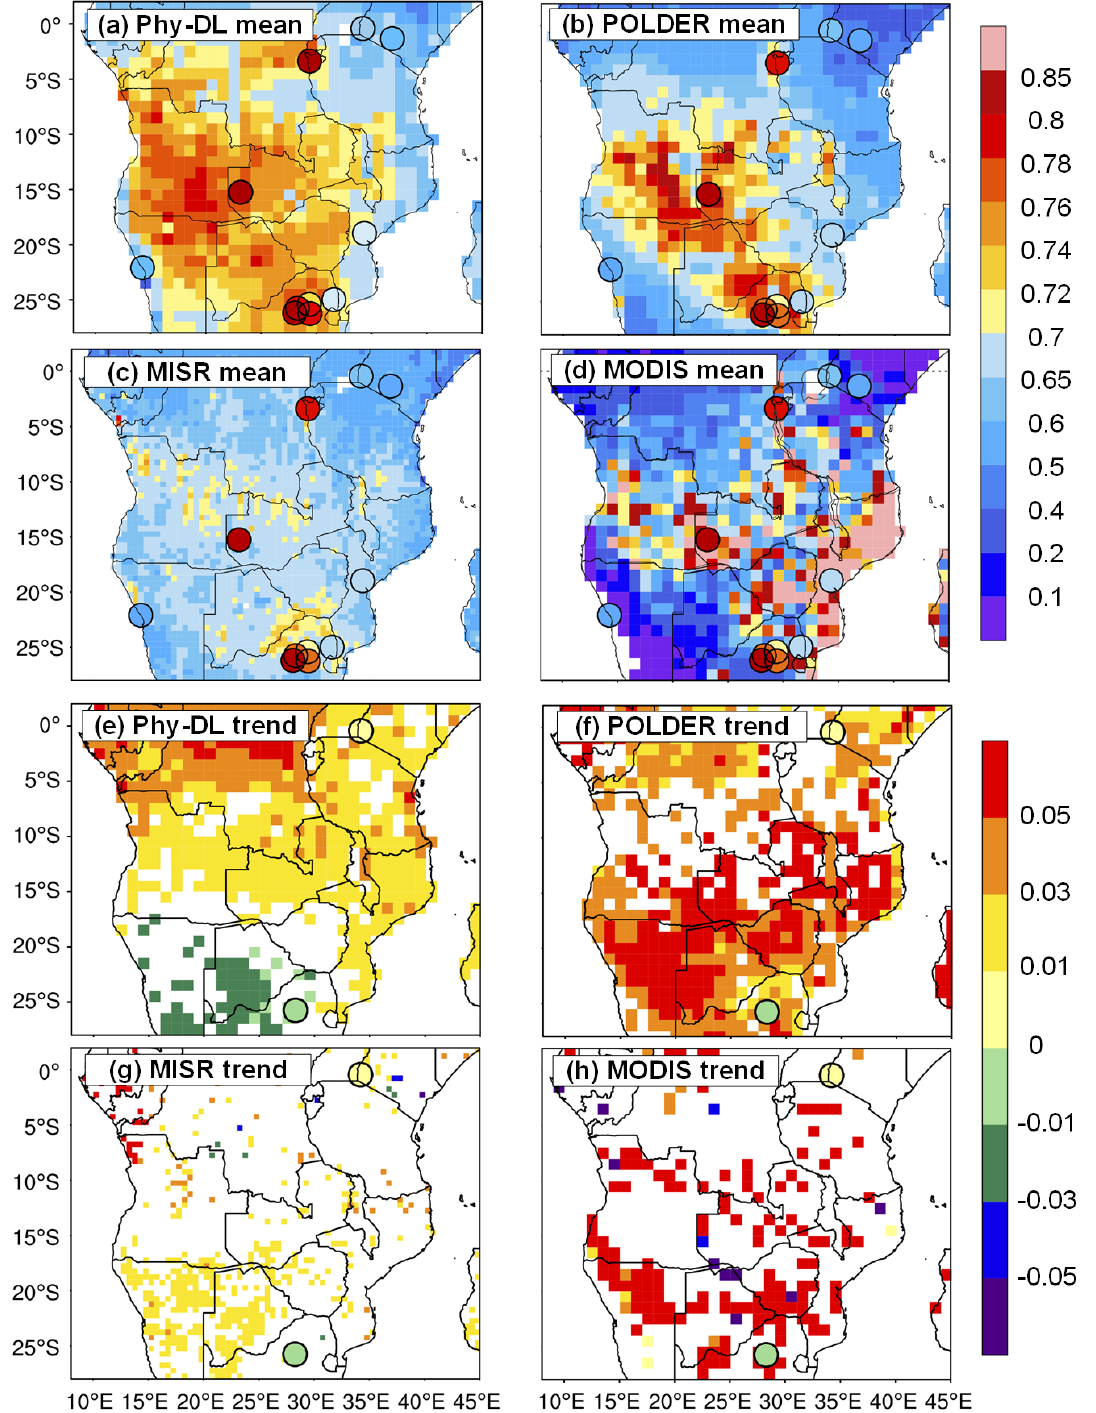
Figure 12. (a–d) Spatial distributions of annual mean FMF (averaged from 2008 to 2013) over Central Africa based on Phy-DL, POLDER, MISR, and MODIS. The colored dots show annual mean AERONET FMF. (e–h) Spatial distributions of the FMF linear trend from 2008 to 2013 over Central Africa based on Phy-DL, POLDER, MISR, and MODIS. The colored dots show linear trends at the AERONET sites. Only pixels and dots with linear trends at the 95% significance level are shown.